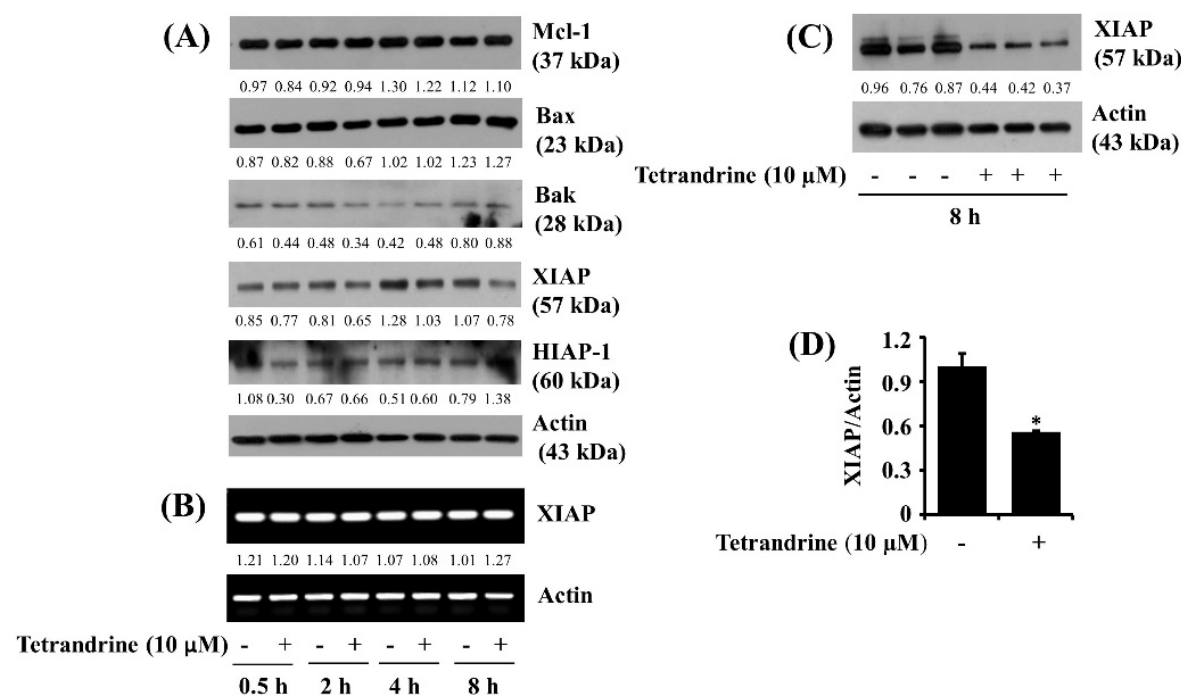
Figure 4. Effects of tetrandrine on the expression of the IAPs and Bcl-2 family members in SW872 cells. ( A ) SW872 cells were treated with vehicle control (0.1% DMSO) or tetrandrine at 10 µ M for the indicated time point. Whole-cell lysates from the conditioned cells were prepared and analyzed by Western blotting to measure the expression of Mcl-1, Bax, Bak, XIAP, HIAP-1, or β -actin. ( B ) SW872 cells were treated with vehicle control (0.1% DMSO) or tetrandrine at 10 µ M for the indicated time point. Total RNA from the conditioned cells was prepared and analyzed by RT-PCR analysis for measurement of the expression of XIAP or β -actin. ( C ) SW872 cells were treated with vehicle control (0.1% DMSO) or tetrandrine at 10 µ M in triplicate for 8 h. Whole-cell lysates from the conditioned cells were prepared and analyzed by Western blotting for measurement of the expression of XIAP or β -actin. ( D ) Densitometry data of ( C ). * p < 0.05 was compared to the value of tetrandrine-free control at the indicated concentrations.